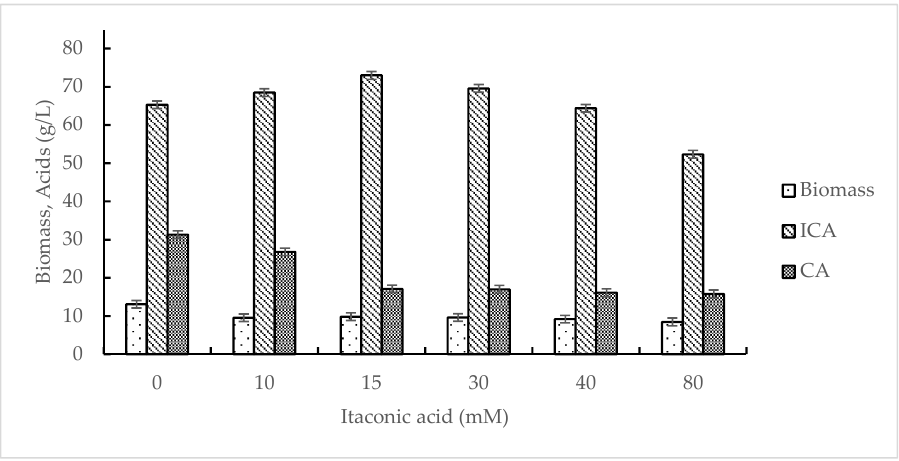
Figure 1. Effect of itaconic acid on the growth of Y. lipolytica VKM Y-2373 and production of isocitric acid (ICA) and citric acid (CA).